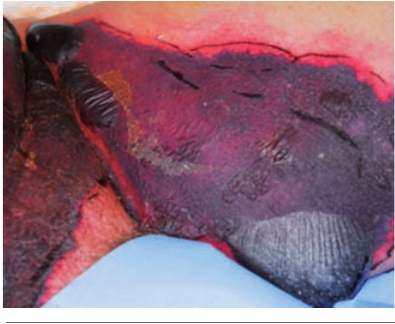
Figure 3. Gross view of left abdominal wall and groin area lesion.